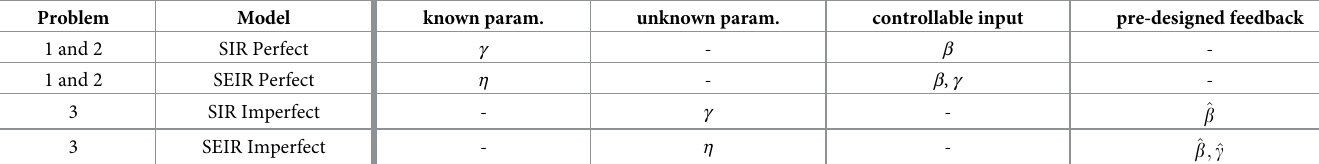
Table 1. Summary of known/unknown parameters and controlled/uncontrolled